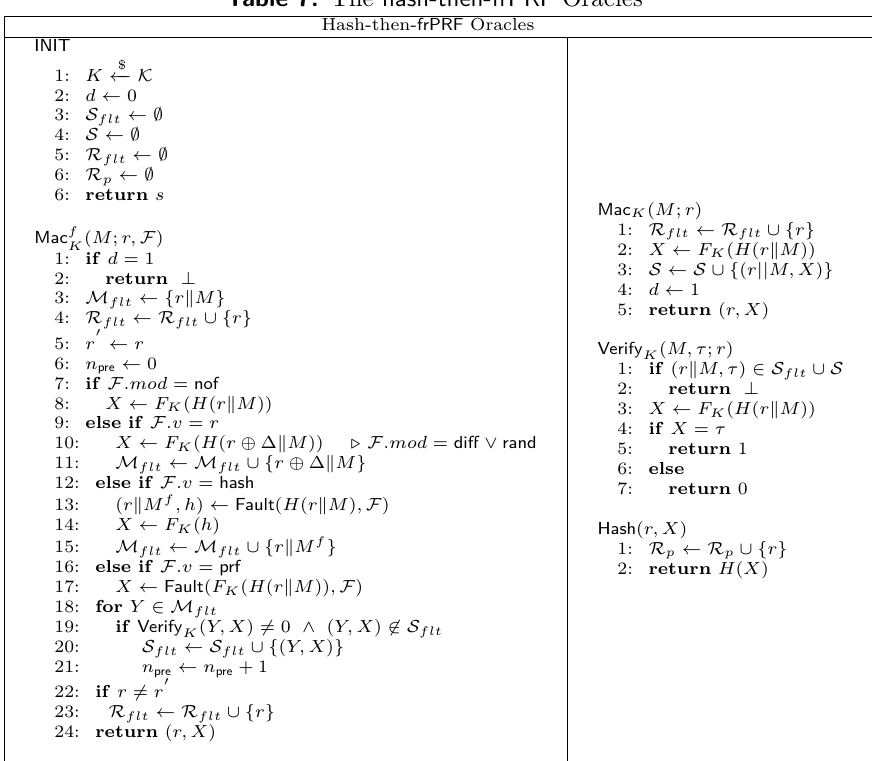
Table 7: The hash-then-frPRF